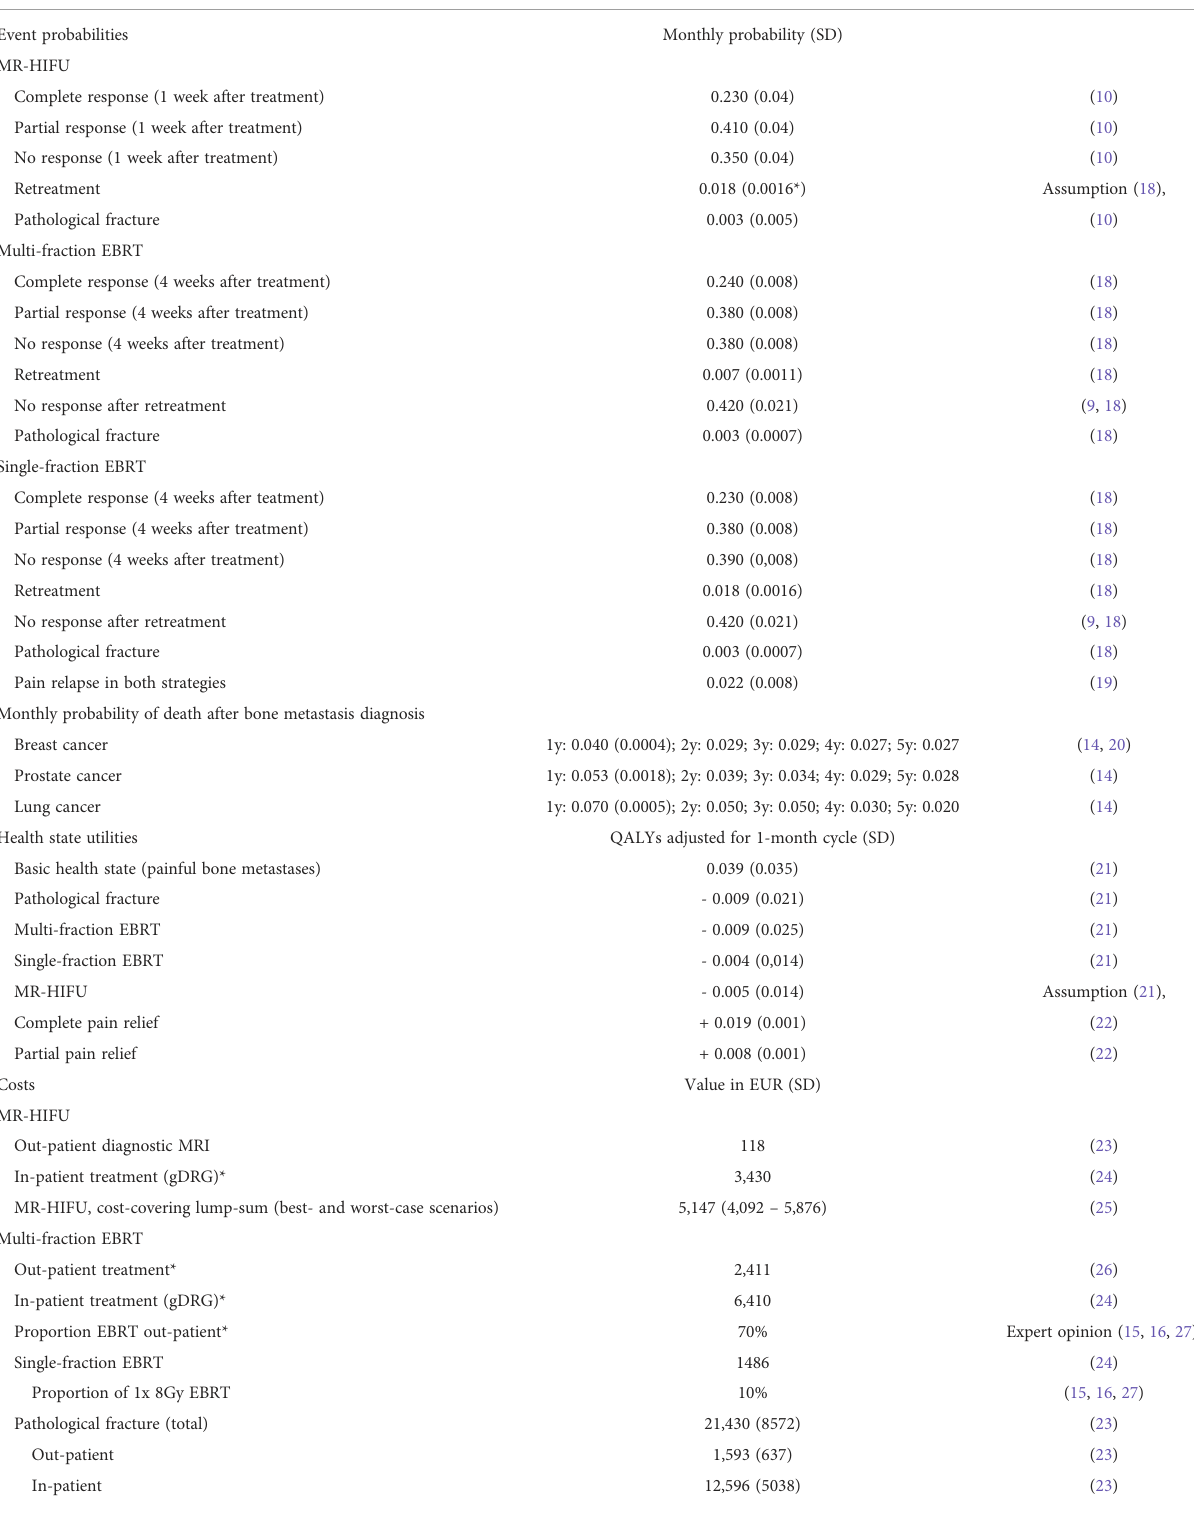
TABLE 1 Model input